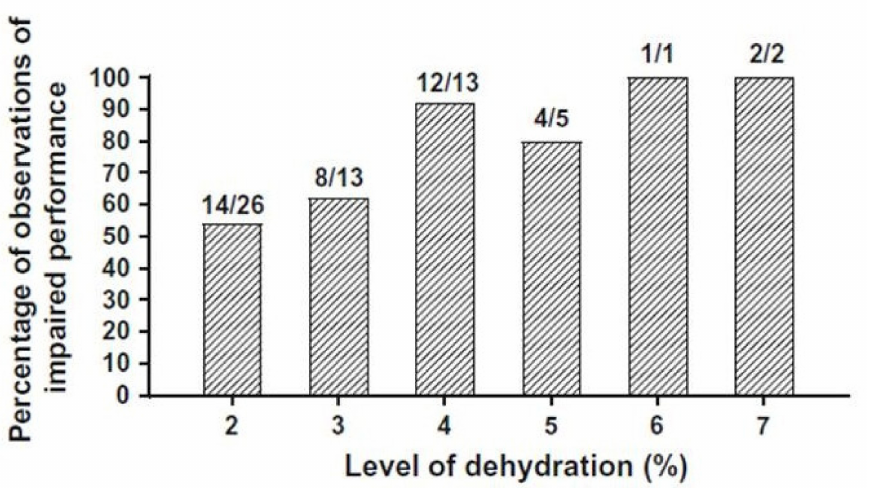
Figure 3. The effects of dehydration on exercise performance. Fractions represent the number of statistically significant ( p < 0 .05) observations out of the number at each level of body mass loss. Across all dehydration levels, 68% of comparisons indicated impairment. Reprinted from [32] via the Creative Commons Attribution 4.0 International License (http://creativecommons.org/licenses/by/ 4.0/) accessed on 2 March